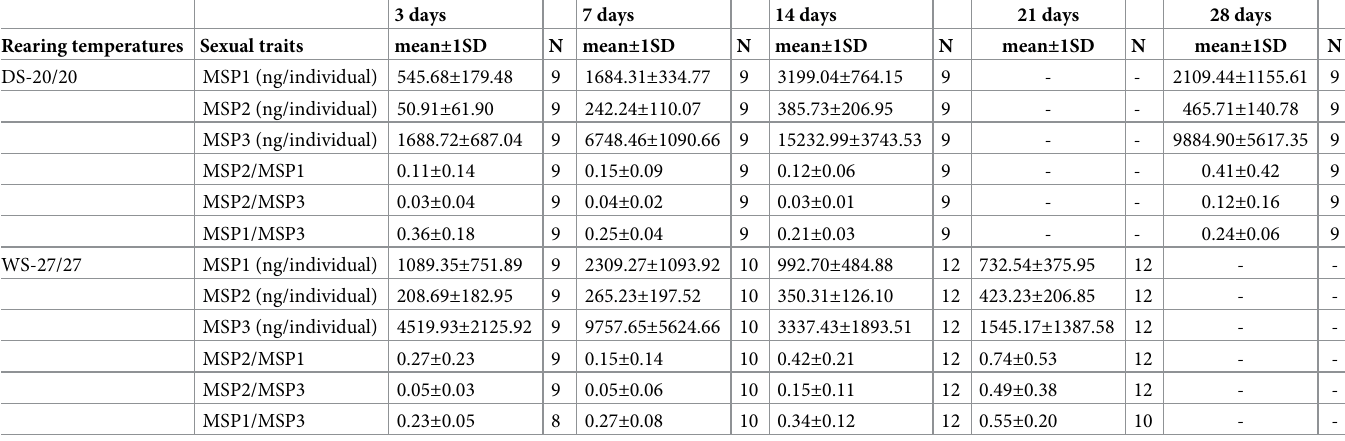
Table 2. Descriptive statistics of the sexually-selected traits per male age and rearing temperature (20˚C and 27˚C) in experiment B obtained from Nieberding et al . [45]’s